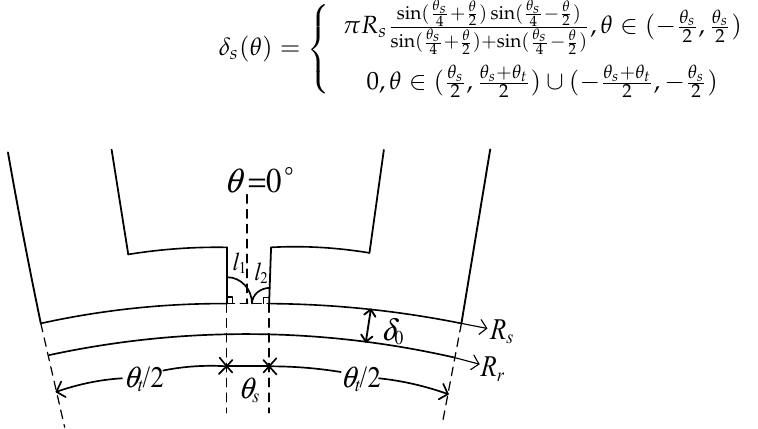
Figure 3. Schematic diagram of magnetic flux lines path in stator slot. The air-gap permeability function of the stator cogging effect can be derived as: